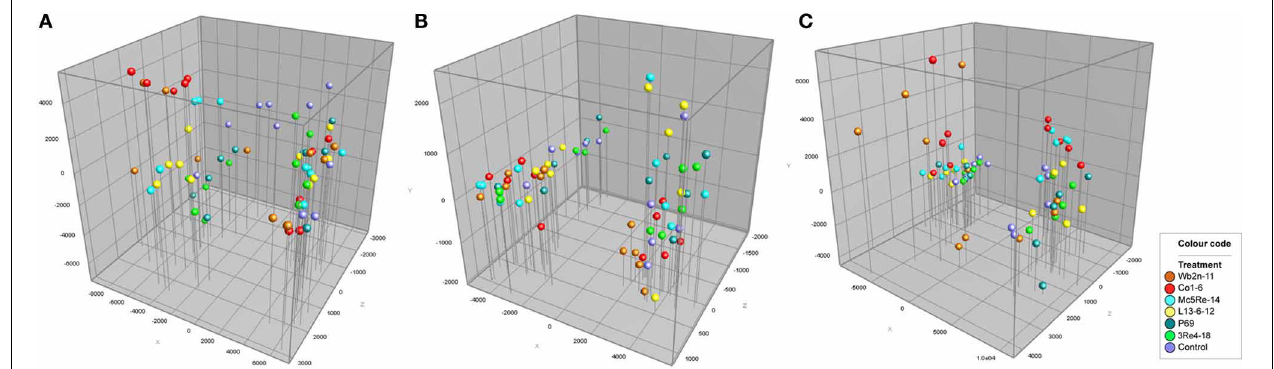
FIGURE 3 | Principal component analysis (PCA) of eubacterial (A), Pseudomonas (B) and Firmicutes (C) community fingerprints. Treatments ( Streptomyces subrutilus Wb2n-11, Bacillus subtilis Co1-6, Paenibacillus polymyxa Mc5Re-14, Pseudomonas fluorescens L13-6-12,